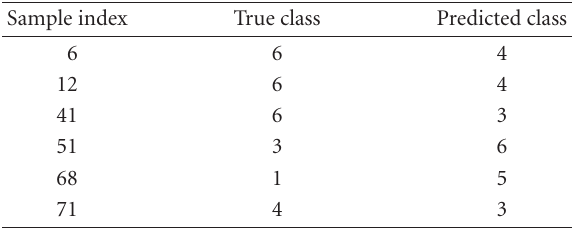
Table 2. Misclassifications of lung cancer.